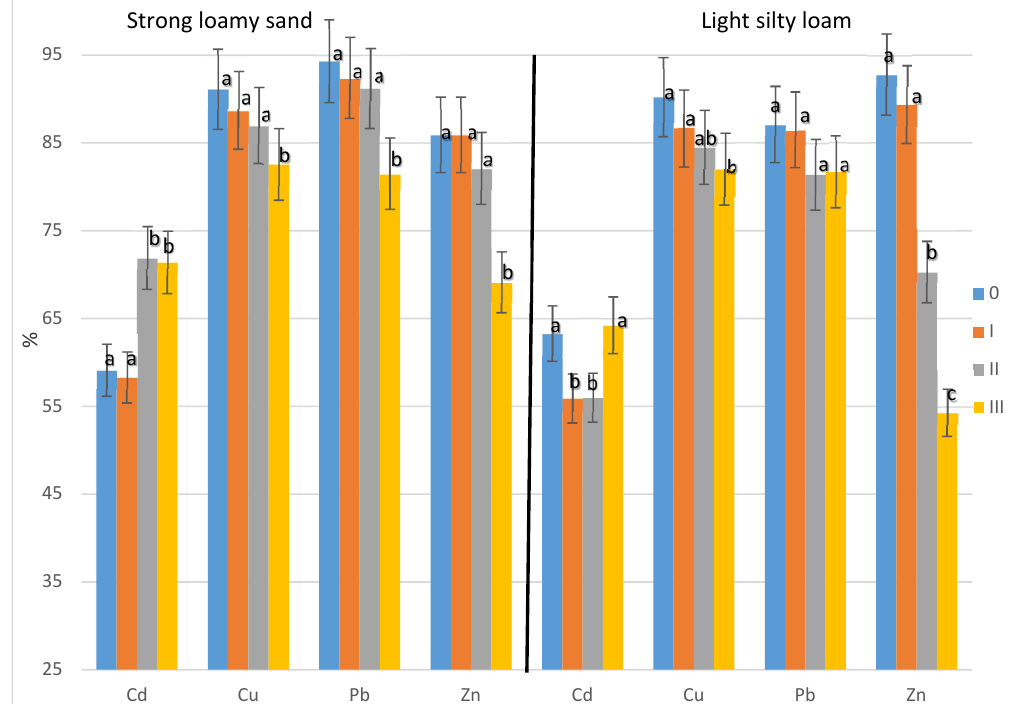
Figure 2. Percentage of heavy metals determined in 1 M HCl (%) in the total concentration of these elements determined in royal water according to soil contamination levels. a, b, c—treatments with the same letter are not significantly different ( p ≤ 0.05).